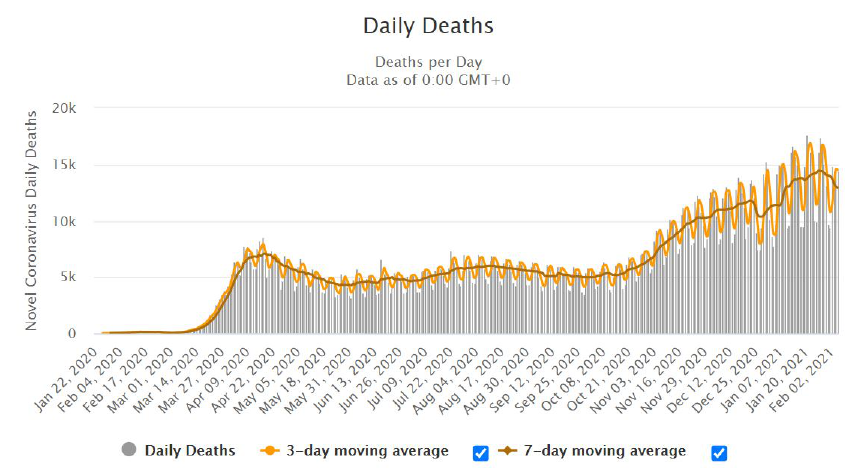
Figure 3. Worldwide daily COVID-19 deaths